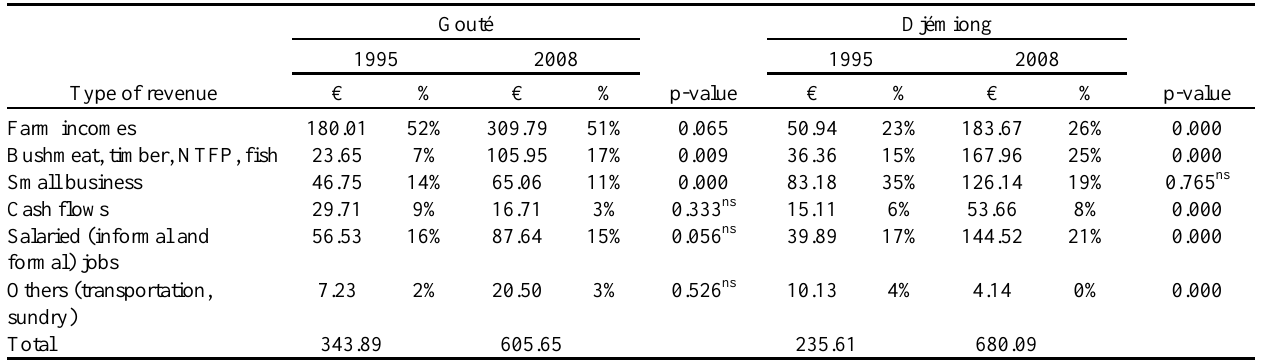
Table 5 . Gross annual average income per household in the two